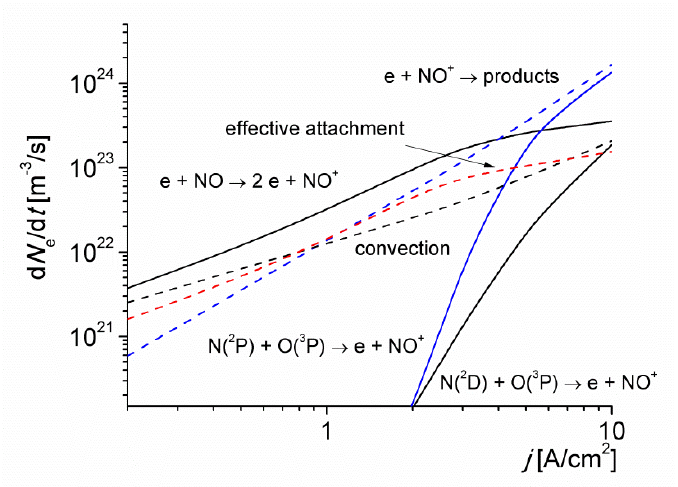
Figure 3. The number density of selected neutral species versus the discharge current density for T 0 = 1800 K.